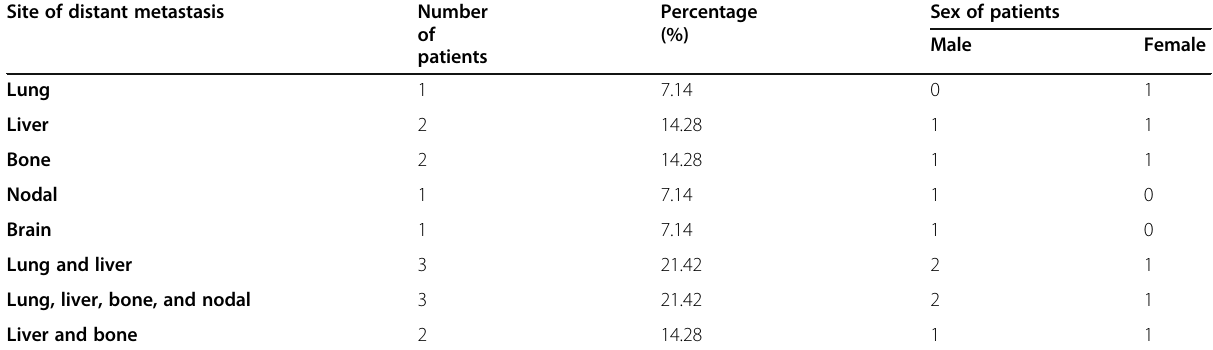
Table 6 Distribution of metastases in different organs ( n = 15) Site of distant metastasis